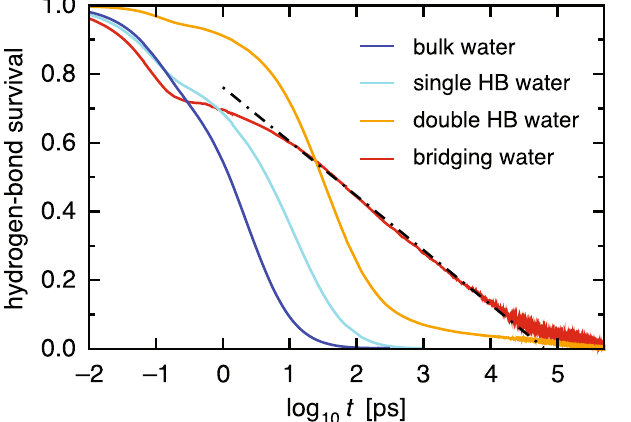
Figure 4. Hydrogen-bond time-correlation functions for bulk water (blue), single HB water (cyan), double HB water (orange), and bridging water (red) versus the logarithmic time axis. Dashed-dotted line denotes the fit by a logarithmic function.